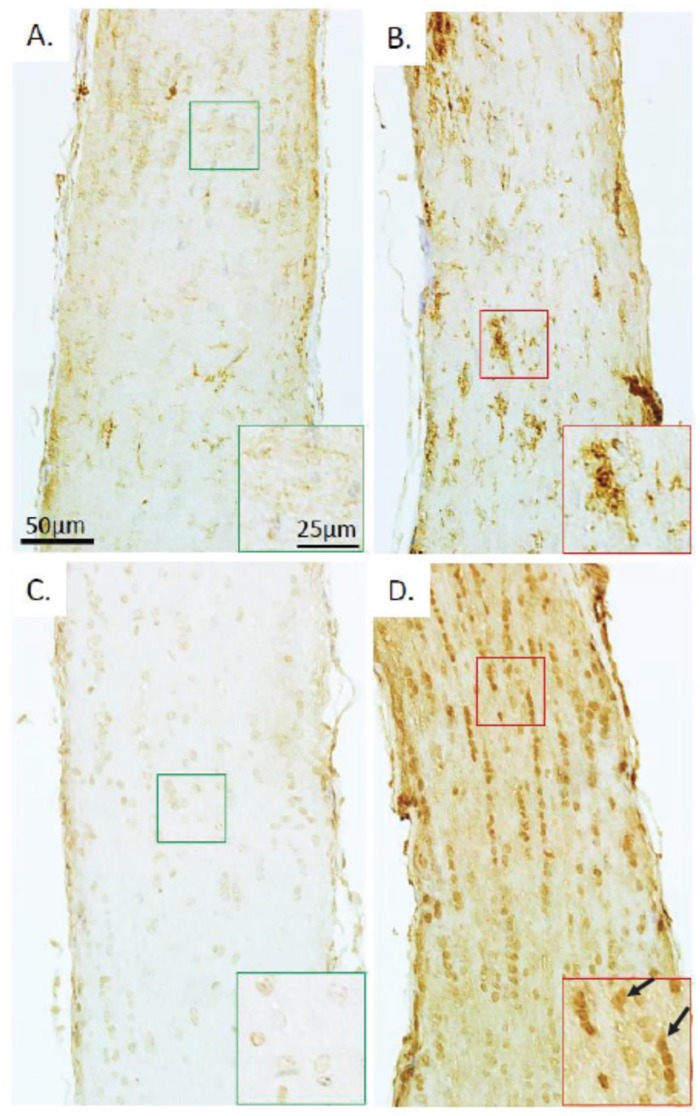
Leucocyte infiltration and microglial activation in optic nerve after r-mTBI.Staining for leucocyte marker CD45 of sections of optic nerves 3 weeks after repetitive anesthesia alone (r-sham) (A) and r-mTBI (B). Ionized calcium-binding adaptor molecule 1 (Iba-1) immunostain of longitudinal sections of optic nerves at the same time point 3 weeks after repetitive anesthesia alone (r-sham) (C) and r-mTBI (D). Higher magnification insets provide further detail, in particular a CD45+ cluster of cells (inset in panel B) and triangularly shaped iba-1+ cells (inset in panel D, arrows).